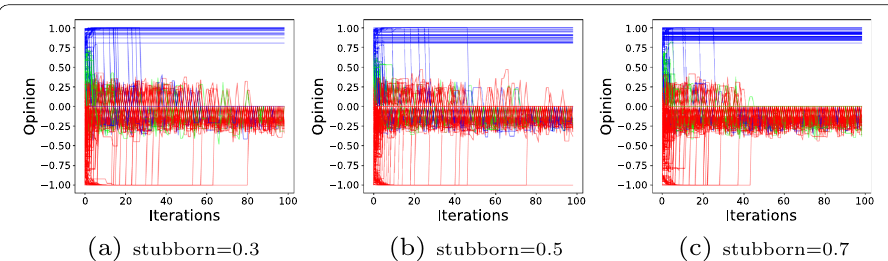
Fig. 7 Effect of the stubborn agents varying their percentage in the RWHK model with ǫ equal 0.85. The stubborn agents opinion is fixed to extreme positive opinion. Stubborn population opinion evolution lines are omitted. The stubborn presence leads to a more chaotic regime towards the opposite stubborn agents’